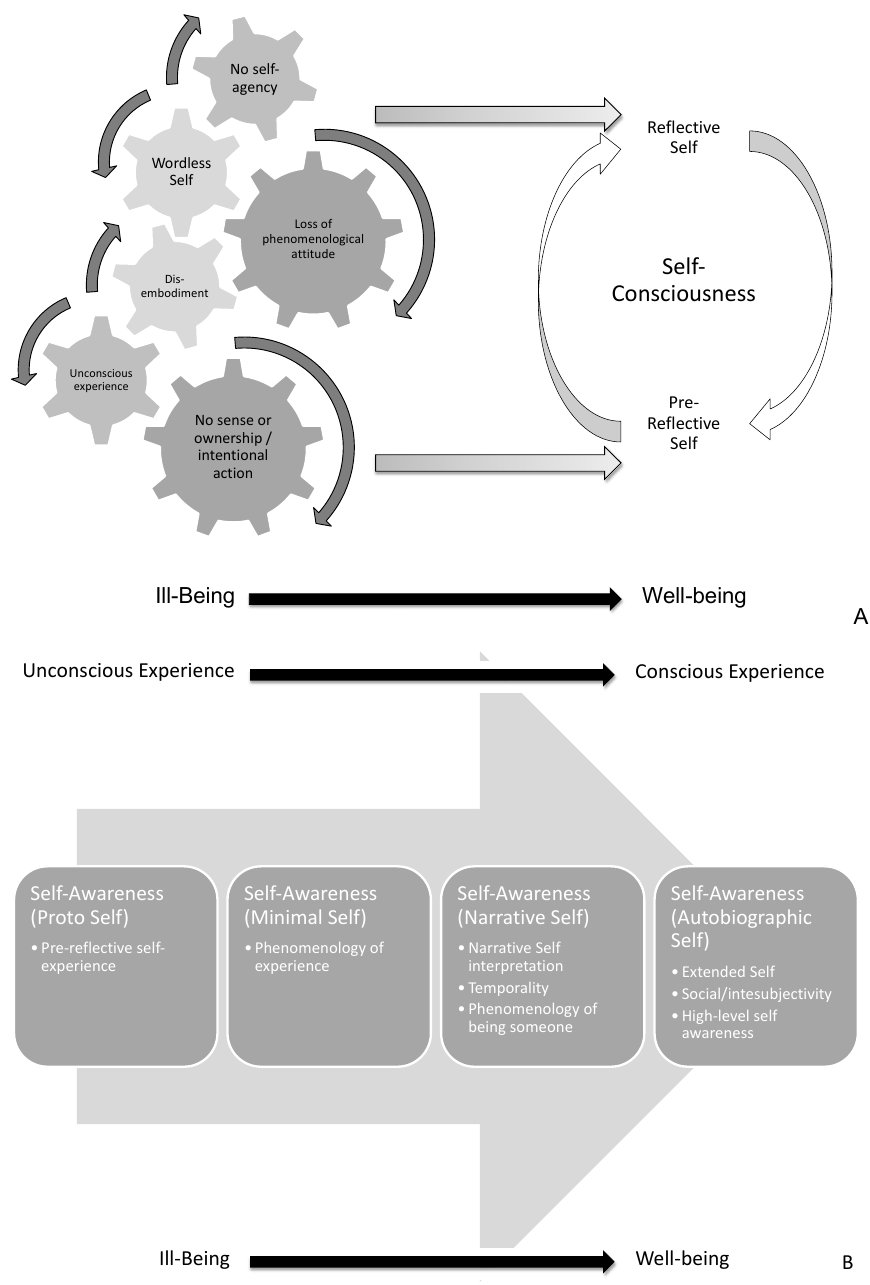
Figure 8. Sample characterization and neurophenomenology schematics ( A , B ). 2 graphical representations of the cognition of the neurotypical self are presented. In ( A ), the different constructs of self-consciousness are introduced. In ( B ), self-awareness is shown as a progression in a 2-dimensional axis: (a) unconscious to conscious experience and (b) ill-being to